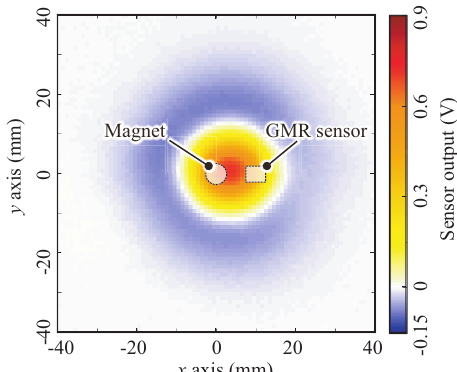
Figure 9. Measured spatial response for a depth of 4 mm. The shape of spatial response exhibits an approximately elliptical Mexican-hat-like bipolar shape whose major axis corresponds to the line connecting the centers of the magnet and GMR sensor.